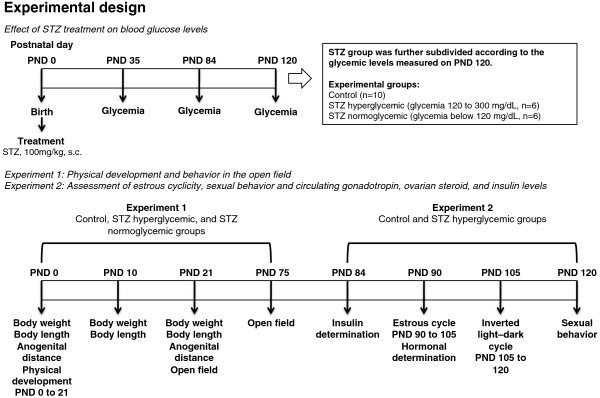
Experimental design.